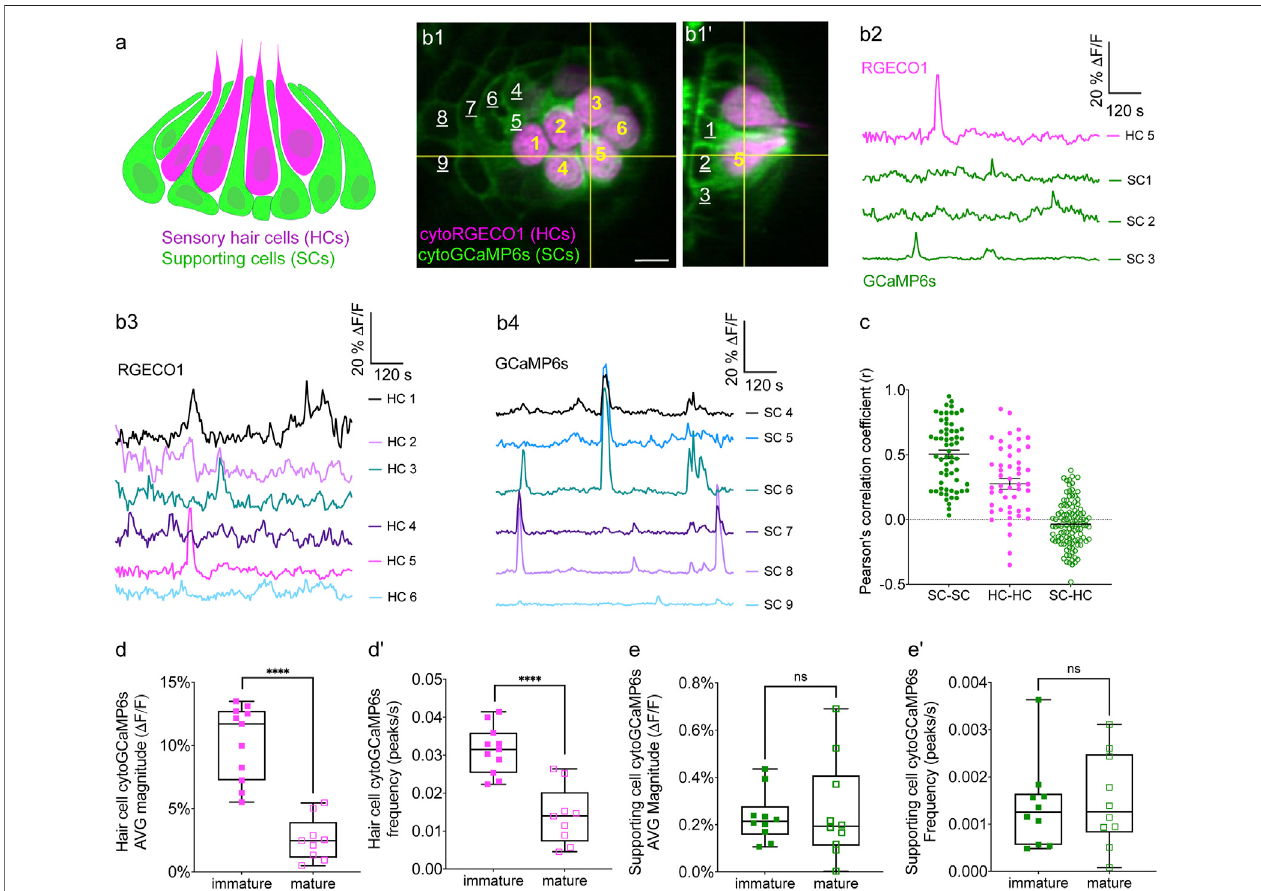
FIGURE 1 | Simultaneous imaging of spontaneous activities in hair cells and supporting cells. (A) Cartoon of a neuromast organ illustrating sensory hair cells (magenta) and the surrounding supporting cells (green). (B1 – B1 9 ) High-resolution images taken using two arms of our diSPIM system show a representative, day 3, double transgenic neuromast expressing cytoRGECO1 (hair cells, numbered in yellow) and cytoGCaMP6s (supporting cells, a subset is numbered in white, underscored). A top-down view (B1) and the corresponding side view of its orthogonal projection (B1 9 ) clearly show the hair cells and the surrounding supporting cells at day 3. (B2) Temporal curves ofspontaneous calcium activity in hair cell 5(labeled in B1 – B1 9 ) and its three surrounding supporting cells (labeled in B1 ′ ) within the 15 min recording window show distinct time courses. (B3) Temporal curves of spontaneous calcium activity in the cluster of six hair cells (labeled in B1 ) reveals distinct response pro fi les. (B4) Temporal curves of spontaneous calcium activity in the seven supporting cells (labeled in B1 ) reveals some correlation and synchronization among neighboring supporting cells. (C) Comparisons of Pearson ’ s R of spontaneous calcium activities at day 3 in neighboring supporting cells, neighboring hair cells and hair cells with its surrounding hair cells, n = 6 neuromasts for HC-HC or SC-SC R values and n = 4 neuromasts for HC-SC R values. (D – D 9 ) Box plots showing quanti fi cation of the average magnitude (D) and frequency (D 9 ) of spontaneous calcium activity in immature (day 3) and mature (day 6) hair cells. (E – E 9 ) Box plots showing quanti fi cation of the average magnitude (E) and frequency (E 9 ) of spontaneous calcium activity in supporting cells in mature (day 6) and immature (day 3) neuromasts. Each dot in (D – E 9 ) represents one neuromast. An unpaired t -test was used in (D – E 9 ) . **** p < .0001. Scale bar = 5 μ m.